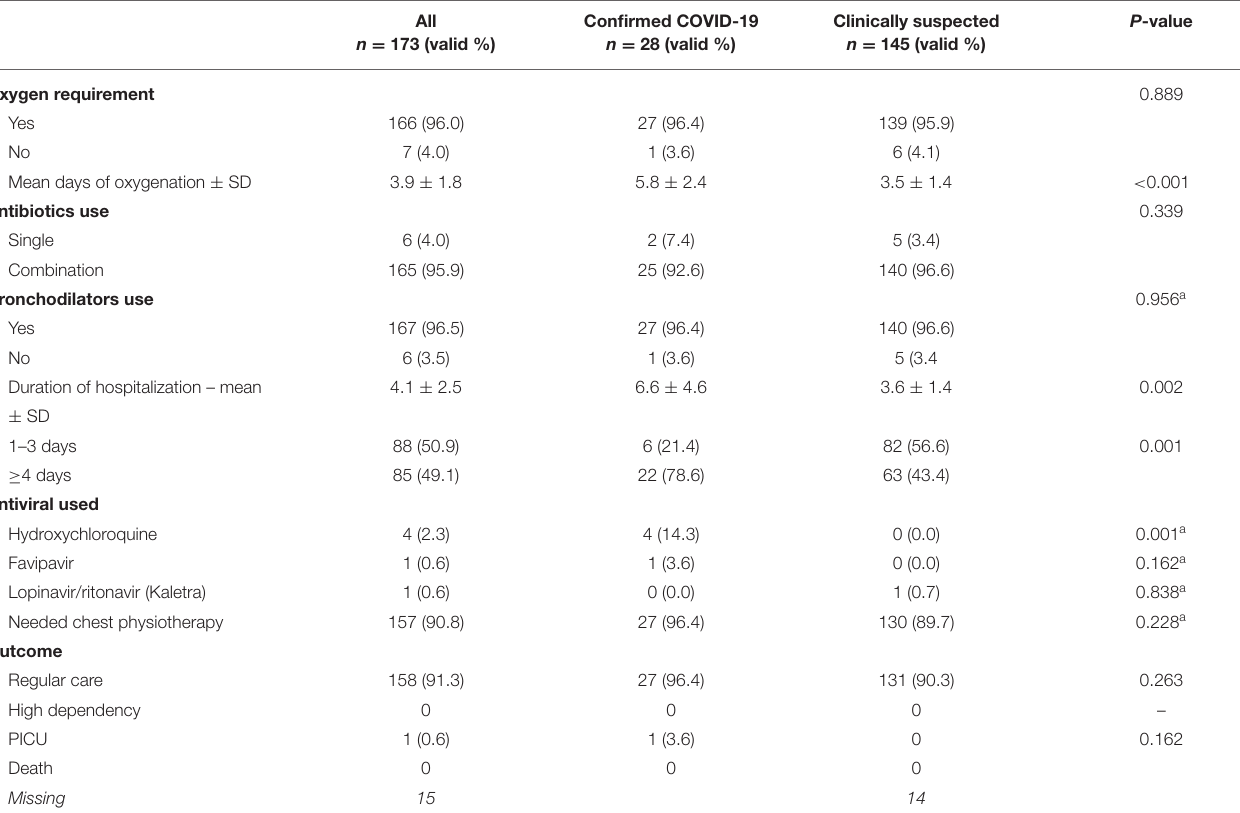
TABLE 3 | Distribution of confirmed (RT-PCR-positive) and clinically suspected COVID-19 (RT-PCR-negative) pediatric patients according to medications used, duration of hospitalization, and clinical outcome. All n = 173 (valid